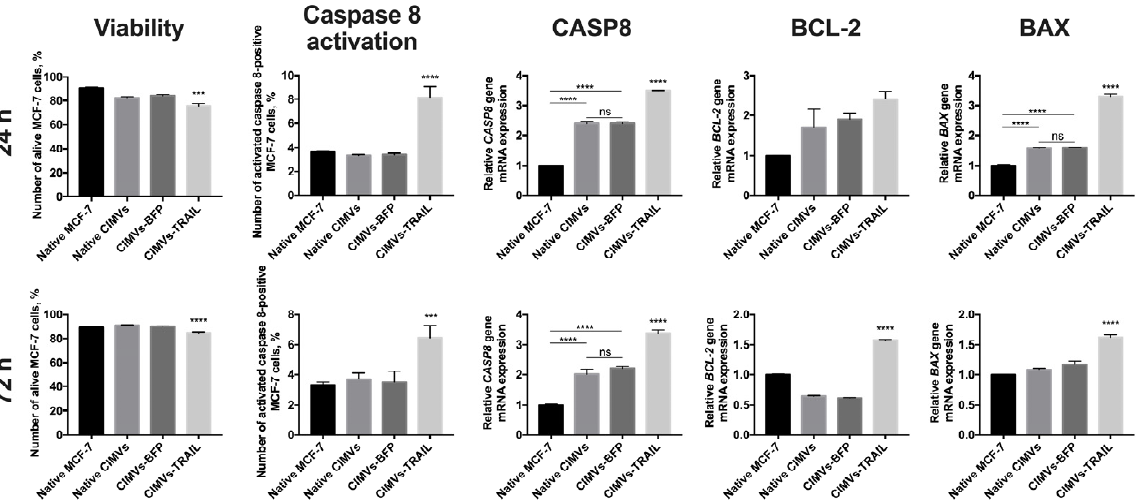
Figure 4. Analysis of the antitumor activity of CIMVs-TRAIL in MCF-7 tumor cell culture. The viability of tumor cells after cultivation with CIMVs was assessed using flow cytometry by staining for annexin and activated caspase 8, the level of mRNA of the apoptosis regulator genes CASP8 , BCL-2 and BAX was assessed by qPCR. The viability of MCF-7 cells was reduced by 15–20% after 24 h of cultivation with CIMVs-TRAIL. At the same time, the mRNA level of the gene of the extrinsic apoptosis pathway regulator CASP8 and the level of activated caspase 8 protein were increased in the tumor cells cultured with CIMVs-TRAIL. The BAX/BCL2 ratio in MCF-7 cells after 24 h and 72 h of cultivation with CIMVs-TRAIL was 1.2 and 1.1, respectively, which also indicates breast cancer cells undergo apoptosis. Each box represents the mean ± SD ( n = 3) of three replicates. **** p < 0.0001, *** p < 0.001, ns—not significant.